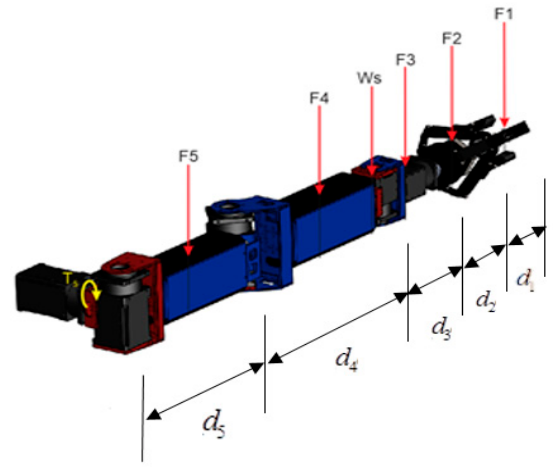
Figure 6. Built-in robotic arm. Figure 6. Built ‐ in robotic arm.